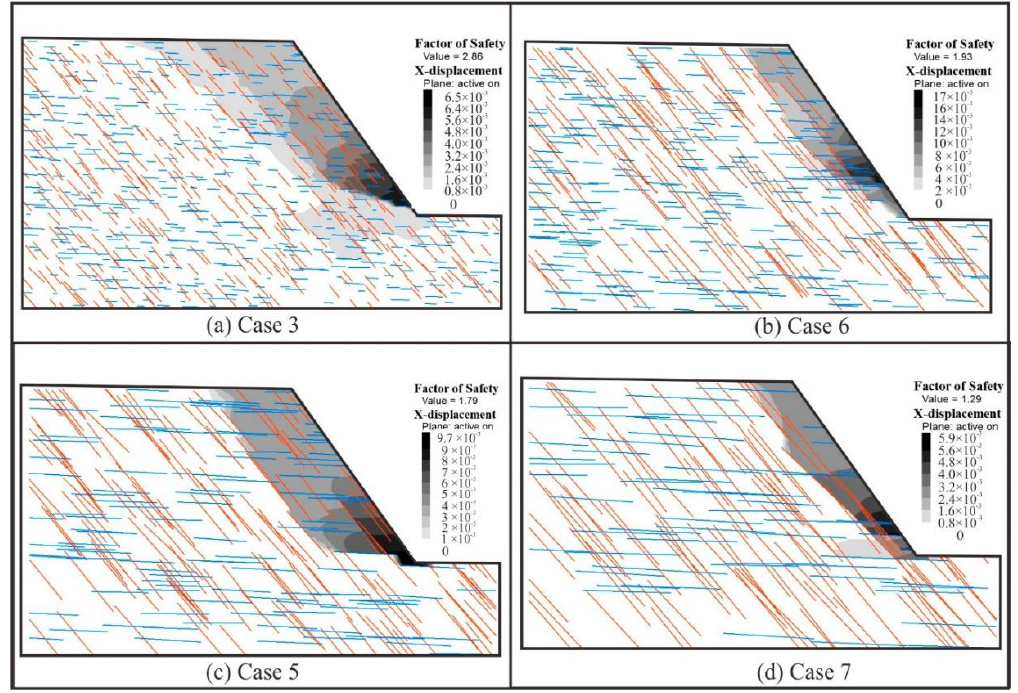
Figure 8. X-displacement contours with different fracture trace lengths.